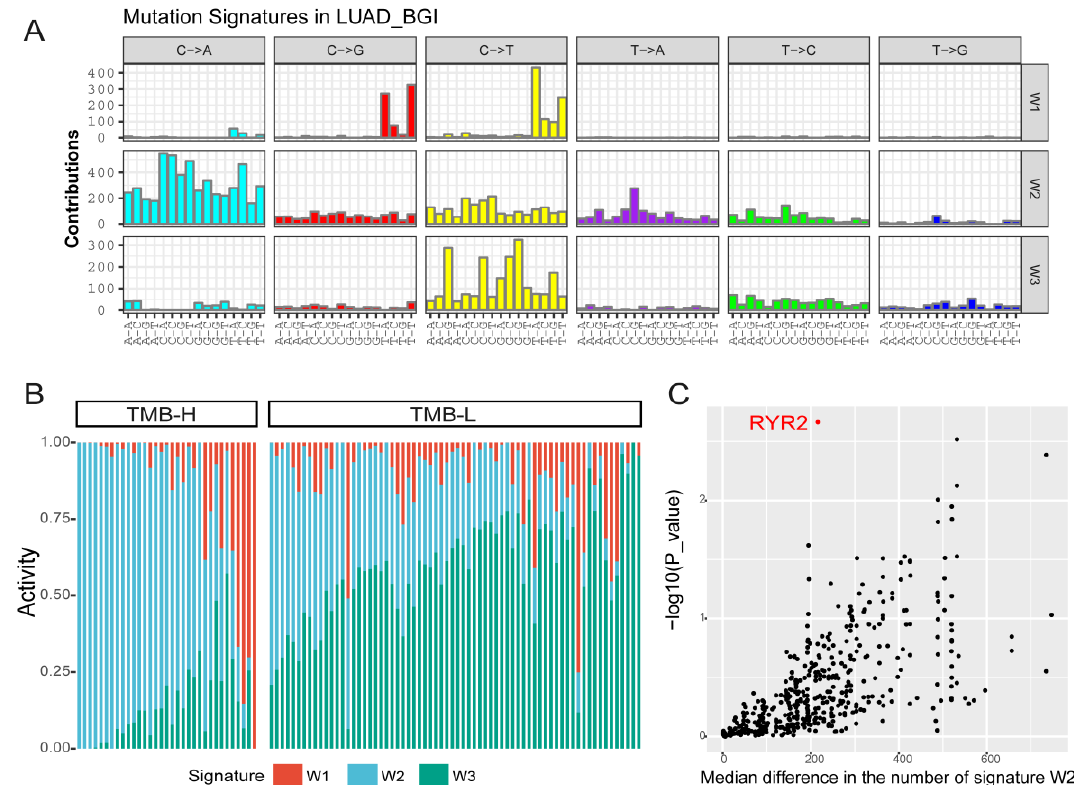
Figure 6. Mutational signature analysis of 101 patients. ( A ) A Bayesian NMF algorithm was applied to identify signatures from the matrix of mutation counts according to 96 types of trinucleotide motifs. Three mutational signatures are identified. ( B ) The distribution of three mutational signatures in the TMB-H and TMB-L groups. Signature W2 is predominant in the TMB-H group. ( C ) Mutation enrichment analysis identifies the association between RYR2 mutations and pattern of Signature W2. RYR2 was the top significant